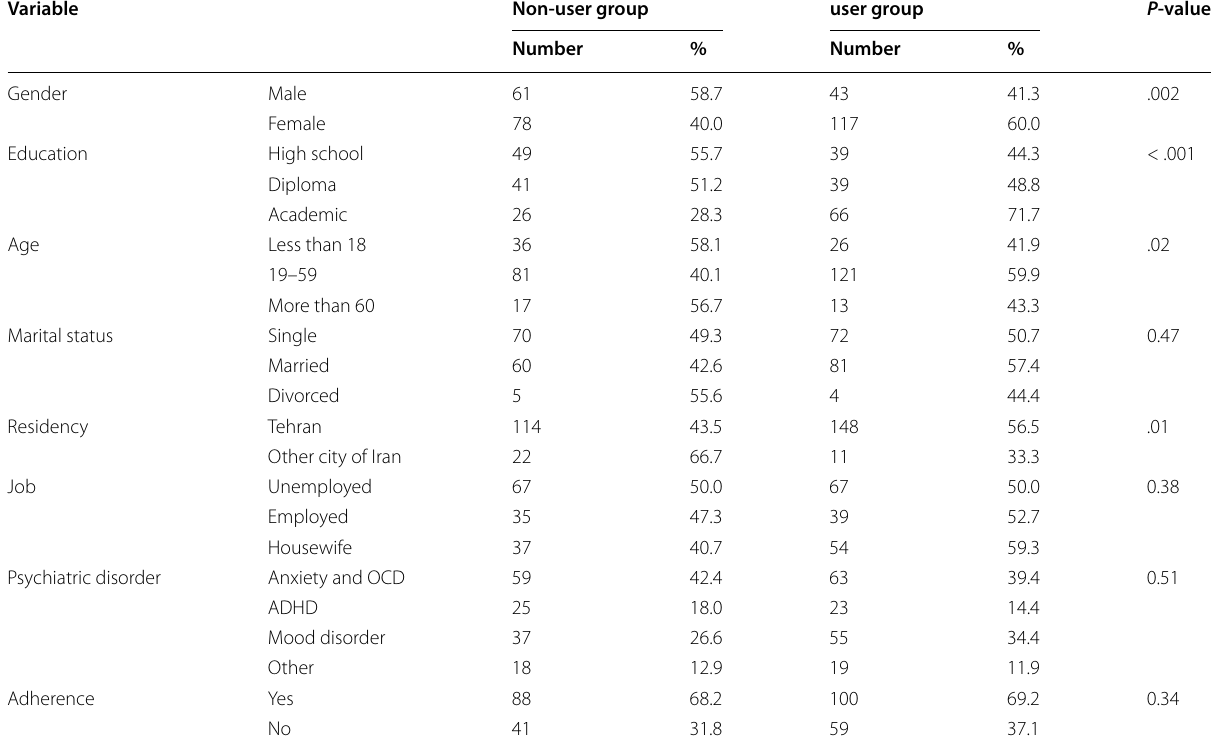
Table 3 Status of service use based on demographic